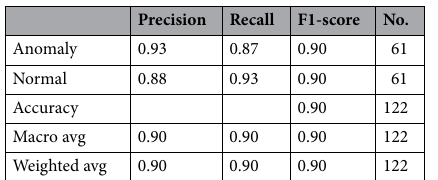
Table 6. The classification results of CNN and LSTM using Leaky ReLU. No. indicates the number of samples.